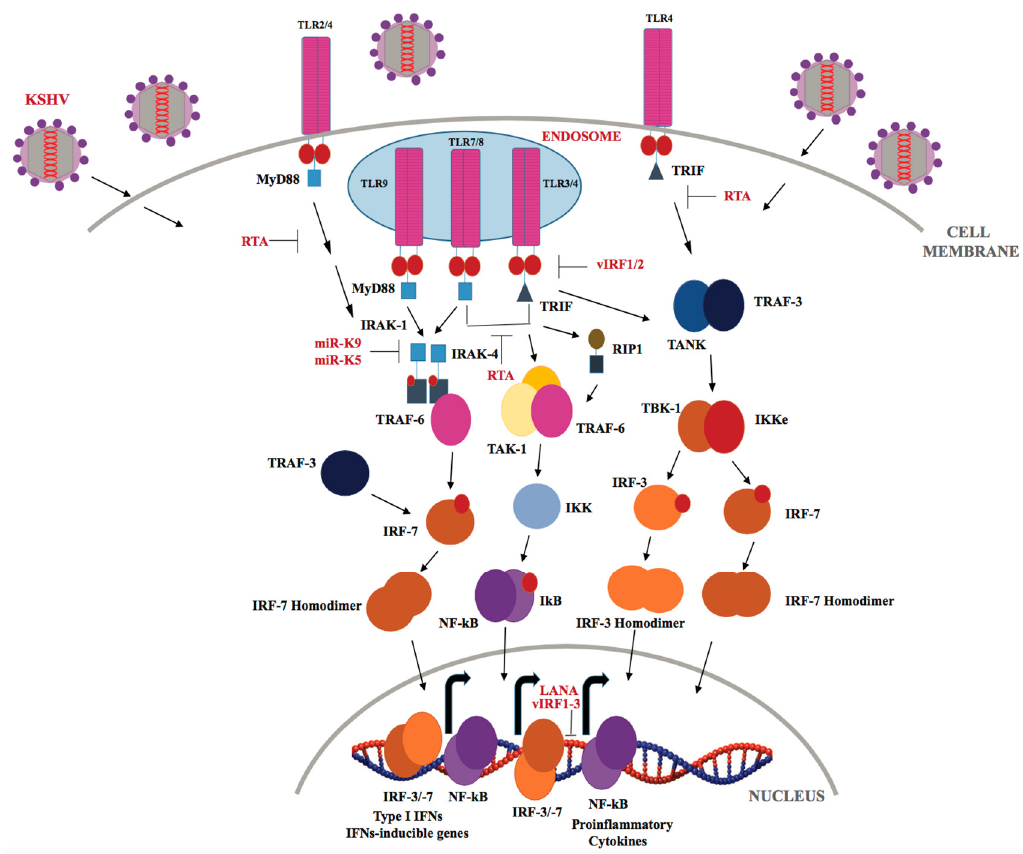
Figure 3. KSHV regulation of the TLR signaling pathway. Upon KSHV infection, TLRs that are expressed either on the cell surface (TLR-2 and 4) or in endosomes (TLR-3, 4, 7, 8, and 9) recruit TIR-domain containing MyD88 and TRIF adaptor molecules. The MyD88 and TRIF molecules then recruit downstream molecules, culminating in the activation of transcription factors such as IRF3/7 and NF- κ B, which regulate the production of type I IFNs and inflammatory cytokines.